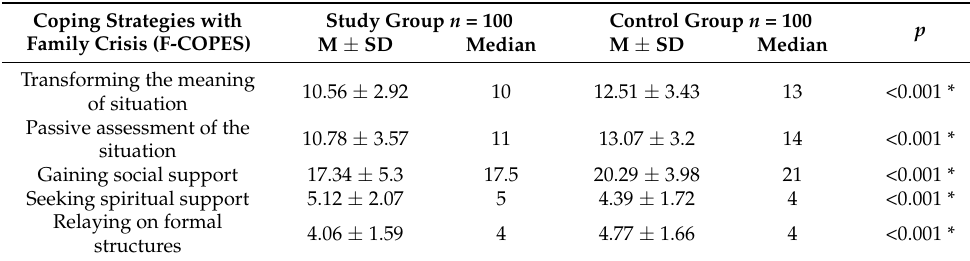
Table 2. Comparison of the results of the F-COPES scale between children and adolescents from the study and control